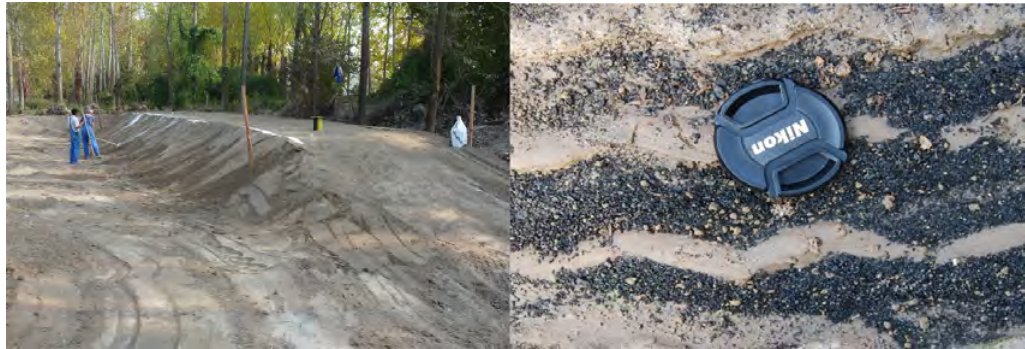
Figure 10. Finished test embankment (left) and the amount of coal particles